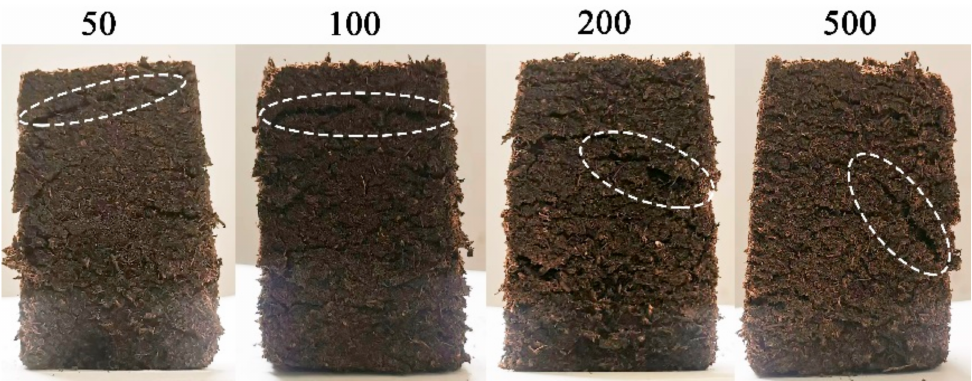
Figure 7. Image of peat substrate blocks with different loading speed after standing 48